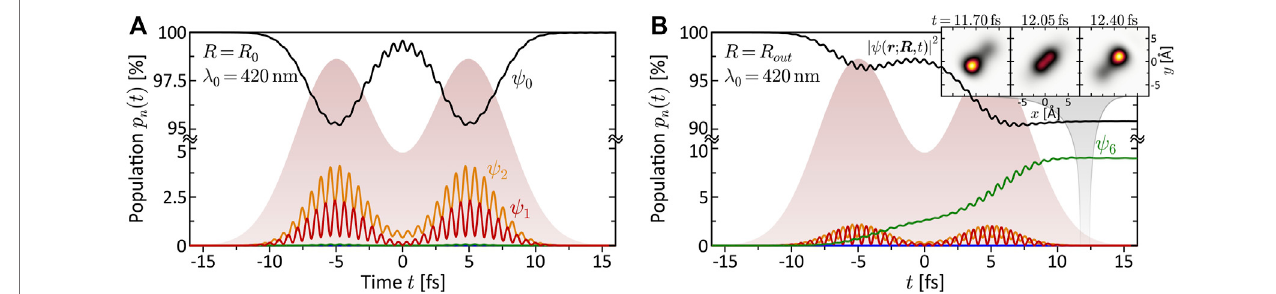
FIGURE 4 | (Color online.) Bound state population dynamics of the rigid molecule excited by the LRCP sequences (shaded background) from the MPI scheme. Shown are the time-dependent populations of the eight lowest electronic states ψ n (cf. Panel 1B ). (A) Non-resonant excitation at the equilibrium distance R 0 = 4.48 Å usingacentralwavelengthof λ 0 =420 nm.Onlystates ψ 1 and ψ 2 aretransientlypopulated,mediatingtheMPIprocess.Finally,almosttheentirepopulationreturnstothe ground state. (B) Resonant excitation of state ψ 6 at the outer turning point R out = 6.0 Å, using the same central wavelength λ 0 = 420 nm as in (A) . The coherent superposition of states ψ 0 and ψ 6 corresponds to an ef fi cient ultrafast charge oscillation in the bound molecular system, illustrated in the inset by a time series of the electron density | ψ ( r ; R , t )| 2